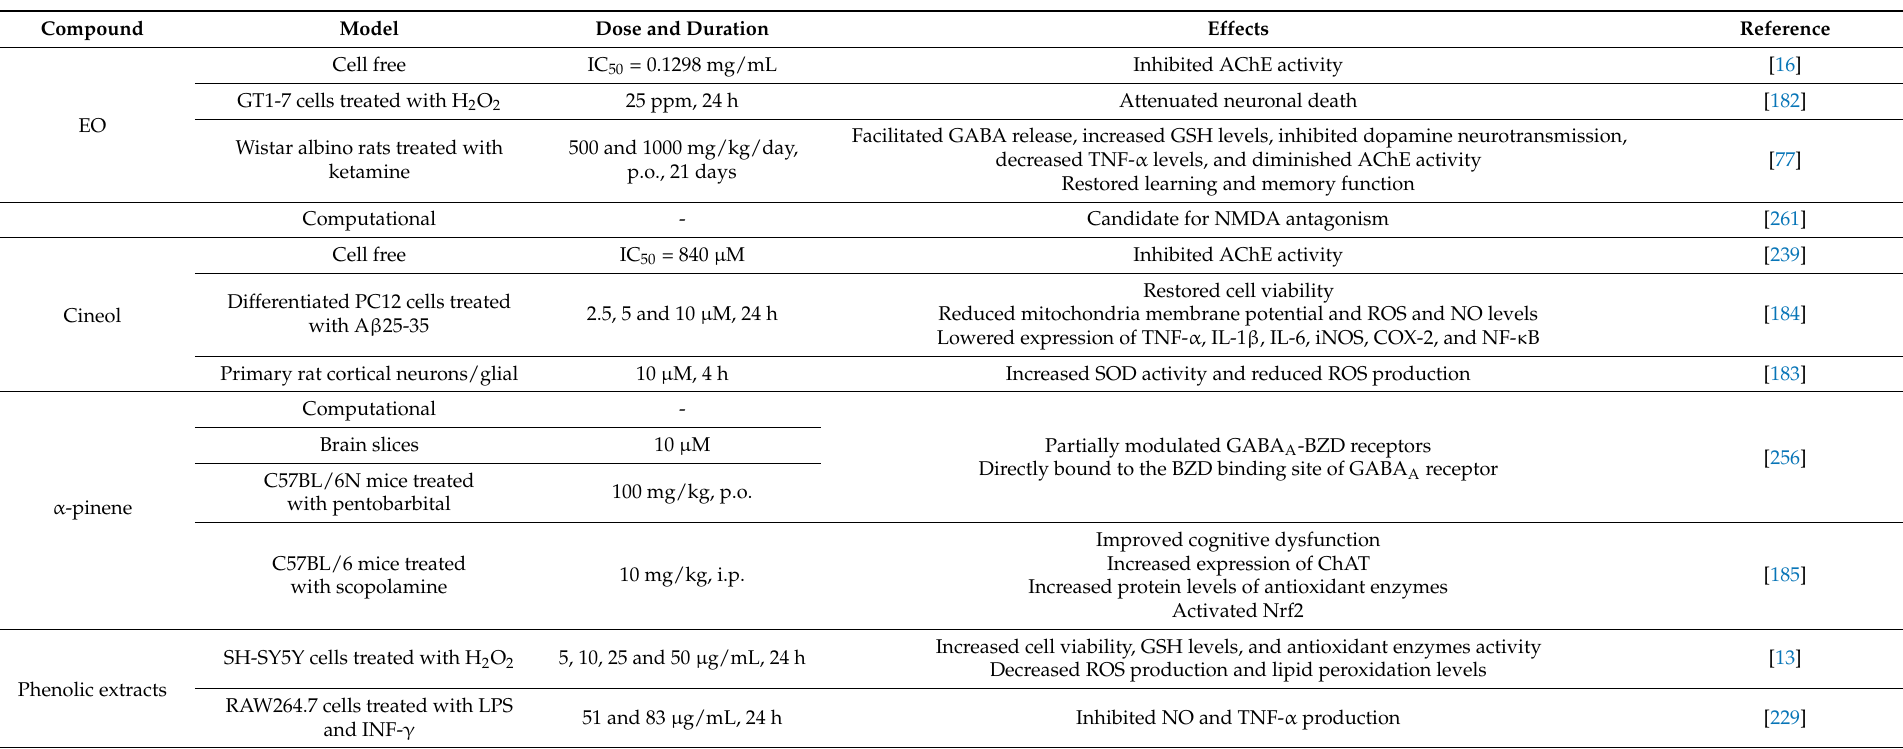
Table 3. Neuroprotective effects of EO, phenolic extracts, and the major constituents obtained from E. globulus leaves against various neurodegeneration model